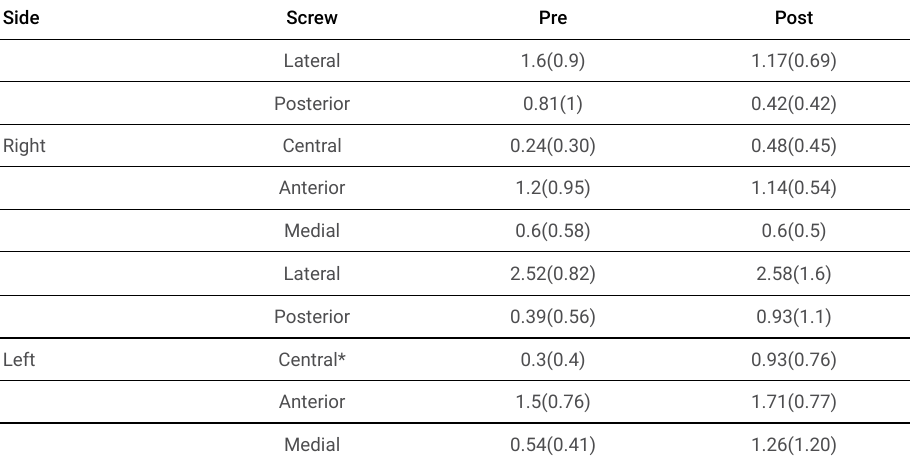
Table 3. Averages, standard deviation (SD) and statistical test result of the vertical distances (sagittal reformatting) between the screws of the glenoid fossa and mandibular condyle in the preoperative and postoperative periods of both sides. *Significant